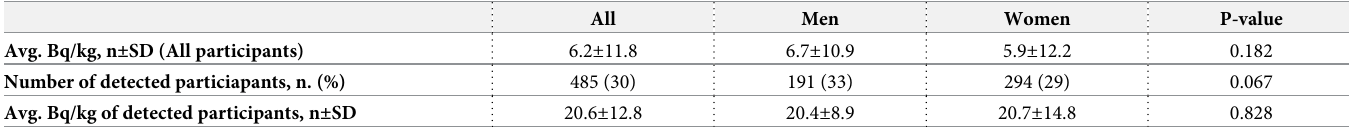
Table 2. Body burden and participants with detected